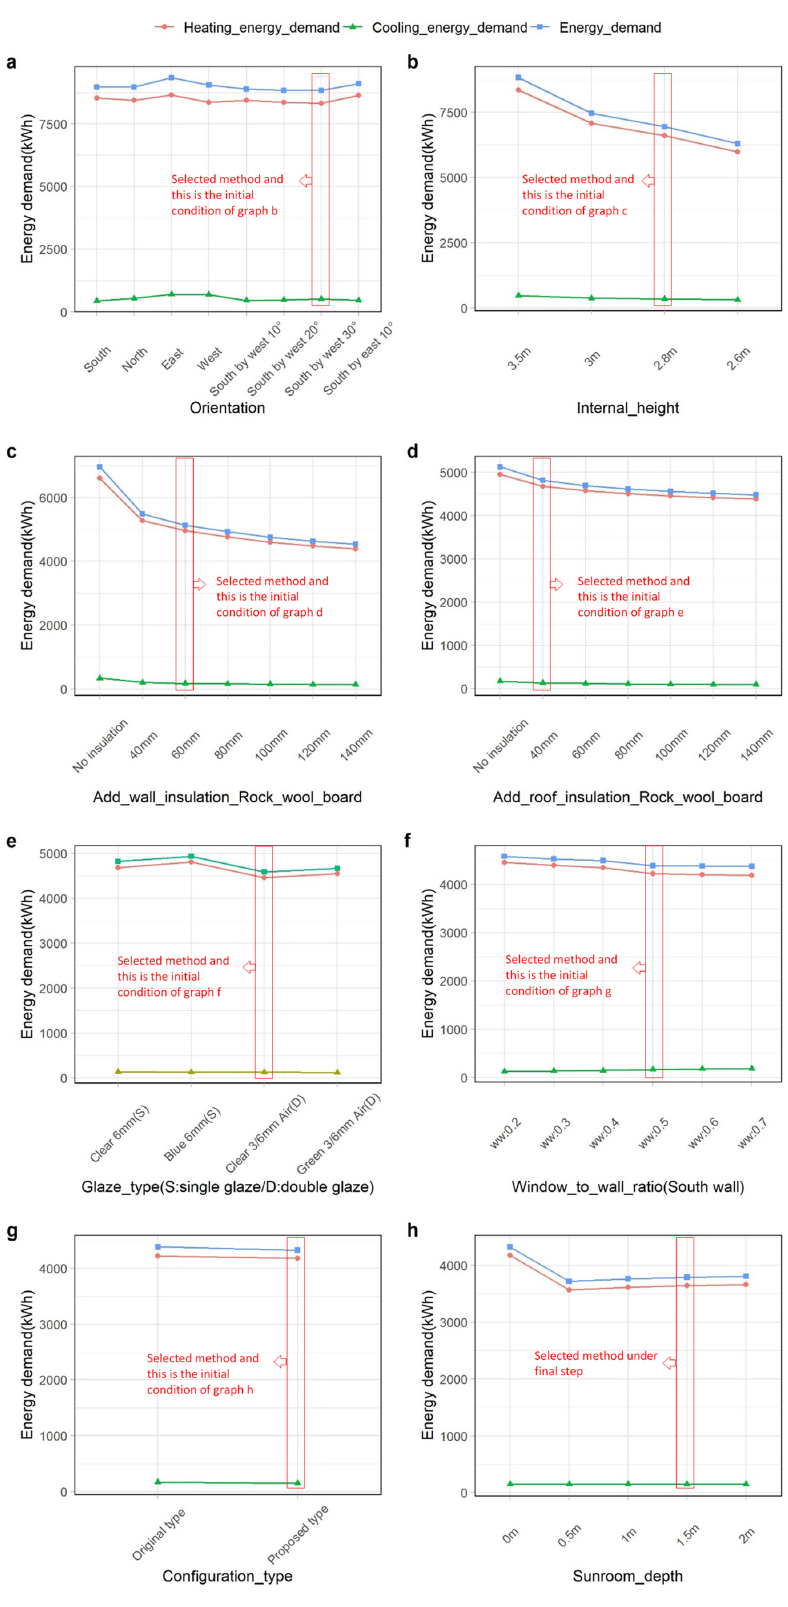
Figure 10. Simulation tests for exploring suitable passive design strategies: ( a ) Analysis of the orientation; ( b ) Analysis of the internal height; ( c ) Analysis of the wall insulation; ( d ) Analysis of the roof insulation; ( e ) Analysis of the glaze type; ( f ) Analysis of the window to wall ratio; ( g ) Analysis of the configuration type; ( h ) Analysis of sunroom